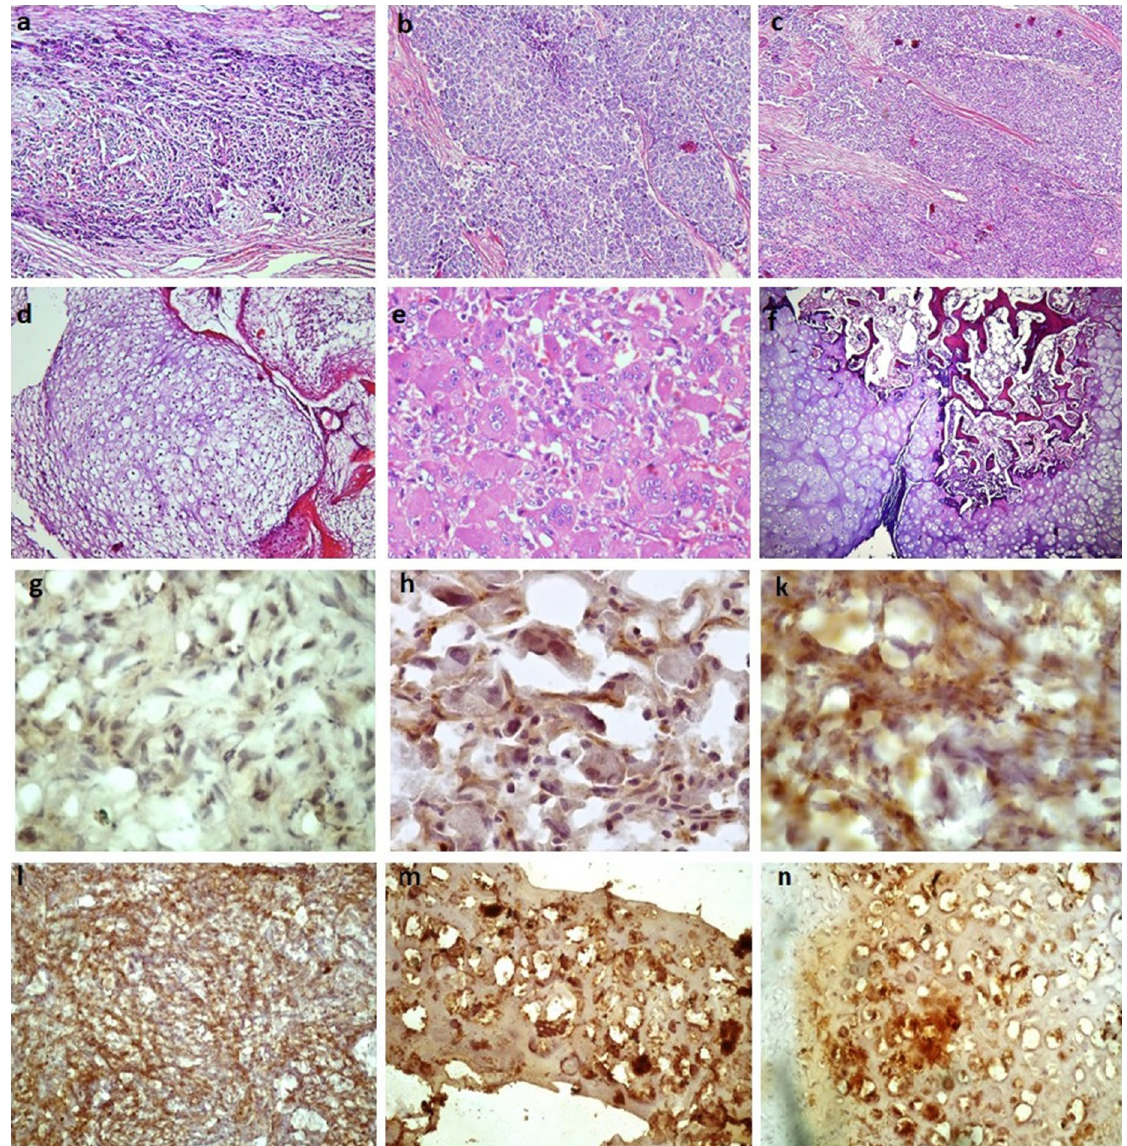
Figure 5. Primary bone tumor histology and immunohistochemistry staining of β-catenin protein. Histopathology with Hematoxylin and eosin (H&E) staining ( a – f ) and immunohistochemistry of β-catenin ( g – n ) in different bone tumor tissues were evaluated. The H&E staining of the osteosarcoma tumor tissue ( a ), Ewing sarcoma ( b , c ), chondrosarcoma ( d ), GCT ( e ) and osteochondroma ( f ) is illustrated. The negative immunoreactivity of β-catenin is shown in ( g ); while ( h ) represents GCT tumor tissue with the weak intensity of β-catenin staining. ( k ) and ( l ) represent GCT tumor tissues with moderate intensity of β-catenin staining, ( m ) represents chondrosarcoma and ( n ) represents osteosarcoma tumor tissue with strong intensity of β-catenin staining. Nuclear localization of β-catenin is shown in osteosarcoma tissue ( n ), cytoplasmic expression of β-catenin is shown in GCT tumor (k ); while chondrosarcoma tumor tissue represents both nuclear and cytoplasmic expression of β-catenin ( m ). The scale of magnification: ( a – f ) 40; ( g – n )